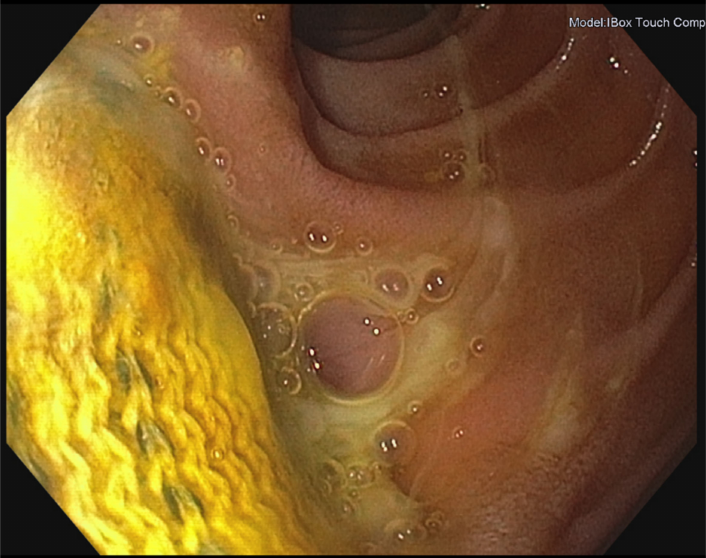
Figure 2. Endoscopic image showing erosion of the prosthetic graft inside the gastrointestinal tract (Department of Internal Medicine I, University Medical Center